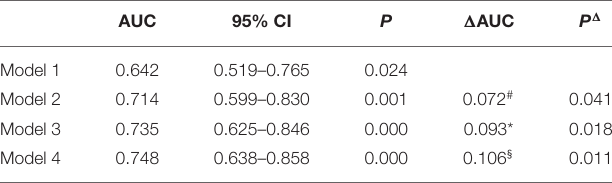
TABLE 5 | The AUC and 1 AUC of the ROC curves from different models and the comparisons. AUC 95% CI P 1